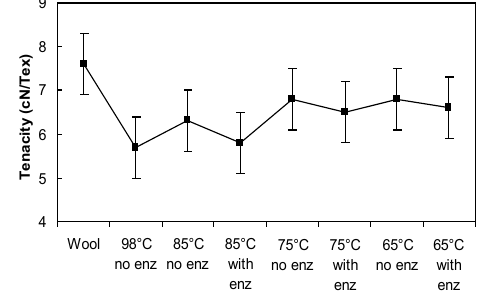
Figure 6. Tenacity measurements on wool yarn dyed in different conditions.